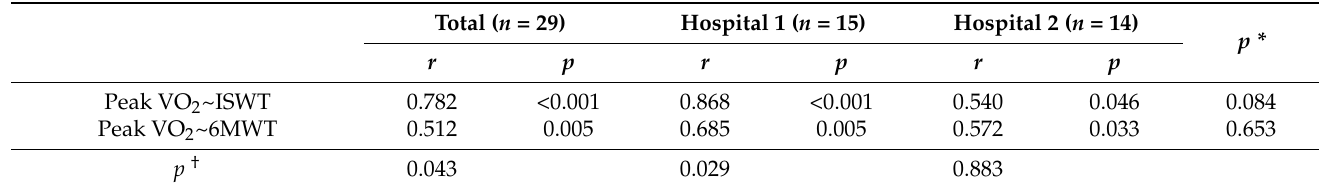
Correlation coefficient ( r ) was analyzed using Pearson’s correlation. * p value was analyzed using the Fisher’s z transformation; † p value was analyzed using Dunn and Clark’s z test. Abbreviations: ISWT, incremental shuttle walking test; 6MWT, 6 min walking test; peak VO 2 , peak oxygen